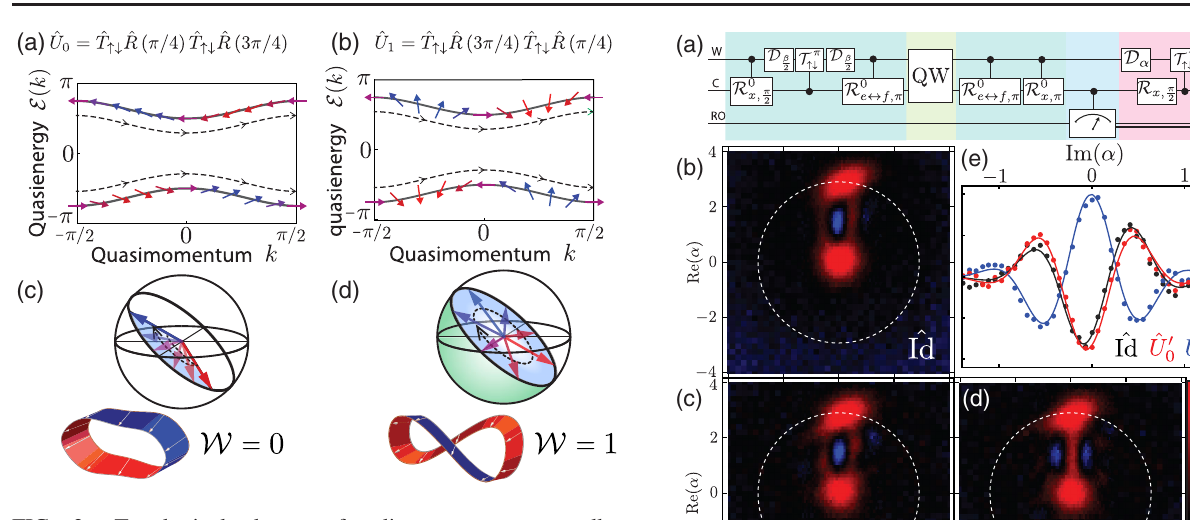
FIG. 3. Topological classes of split-step quantum walks. Calculated band structures, quasienergy ϵ versus quasimomen- tum k , corresponding to the two walks we perform in the ˆ U experiment, (a) and 1 ¼ ˆ R ˆ T ˆ R ˆ T ð 3 π = 4 Þ ð π = 4 Þ (b). Though the energy bands of the ↑↓ ↑↓ two walks are identical, they are topologically distinct, with FIG. 4. Winding number measurement via direct Wigner the topology given by the winding of ⃗ n ð k Þ as k varies through the tomography of refocused Schrödinger cat states. (a) Protocol Brillouin zone, shown in diagrams (c) and (d). In diagram (c), the for measuring topology via a time-dependent walk (Bloch ˆ U ⃗ n ð k Þ does not complete a full revolution around trivial case oscillations). The Schrödinger cat state is first prepared (blue), 0 , ˆ U the Bloch sphere, while in the topological case after which the ten-step refocusing quantum walk is performed 1 diagram (d), it does perform a full revolution. This also provides a direct (green). The qubit and cavity state are then disentangled, the qubit connection to the Berry phase, as for a spin- 1 = 2 system the state is purified (blue), and direct Wigner tomography on the Berry phase is simply half the subtended solid angle of the Bloch cavity state is performed (pink). Wigner tomography of (b) the cat sphere path. A schematic representation of the variation of ⃗ n ð k Þ is undergoing no quantum walk, (c) the cat after undergoing the ˆ U shown by the ribbons below the Bloch spheres. The arrows on trivial 0 walk, and (d) the cat after undergoing the topological these strips point in the direction of ⃗ n ð k Þ . Analogous to the walk. Fidelities of these resulting cat states compared to pure cat number of twists in closed ribbons, winding numbers are states are 0.68, 0.69, and 0.67, respectively. (e) A cut of the quantized and robust to local Wigner function, showing the fringes that encode the relative phase between the two cat components for no walk (black), a trivial walk (red), and a topological walk (blue). The relative phase corresponds to the phase of the measured interference fringes following the relation A exp ½ − 2 j Im ð α Þj 2 (cid:4) cos ½ 2 where A , ϕ are the amplitude and phase of the fringes. The Berry phase — captured by the phase difference between the topological and the trivial walks — is ϕ B ¼ 1 . 05 π (cid:2) 0 . 06 π in experiment, consistent with the theoretical expectations of π .